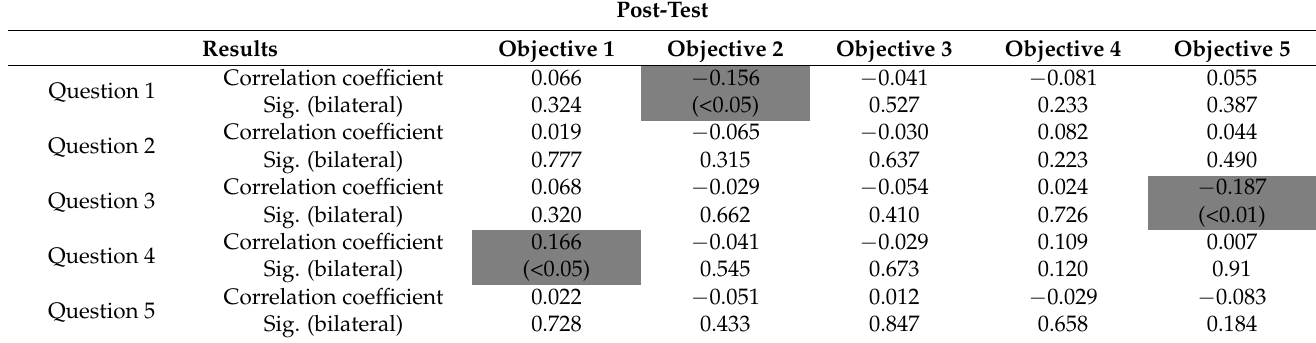
Table 4. Kendall Tau rank’s correlation coefficient and p -values between the course objectives and the